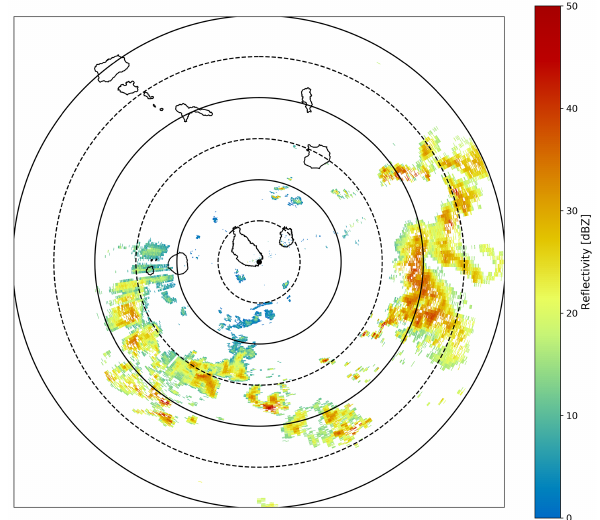
Figure 6. Example of a surveillance-mode PPI observed by NXPol at 20:19UTC on 23 August 2015 while on the ICE-D deployment in Praia, Cabo Verde. Range rings are drawn every 50km. The range ring drawn furthest from NXPol is at 300km. The thick black out- lines are the islands of Cabo